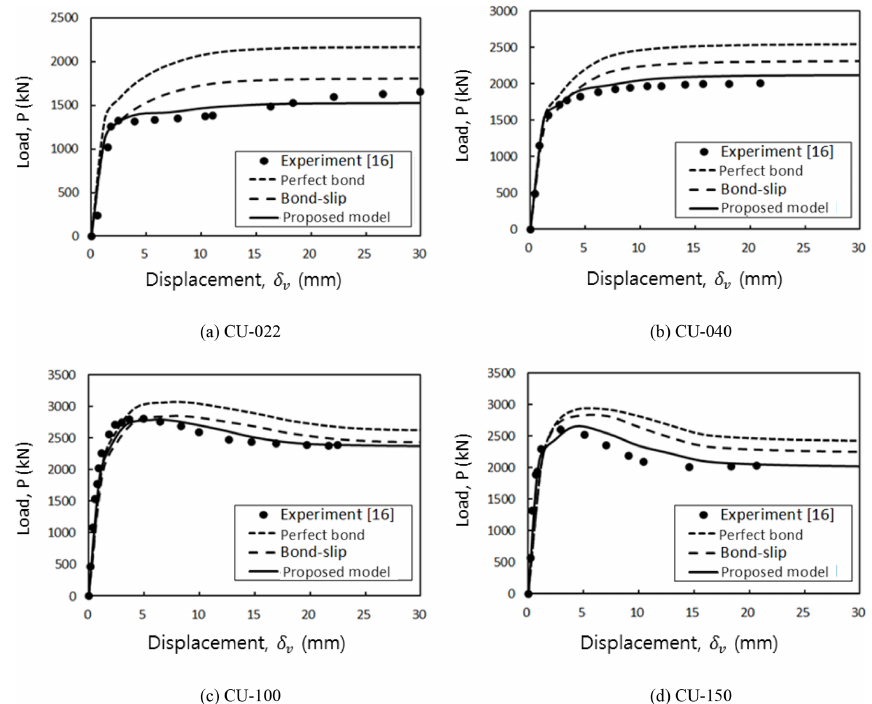
Figure 11. Relation between load and